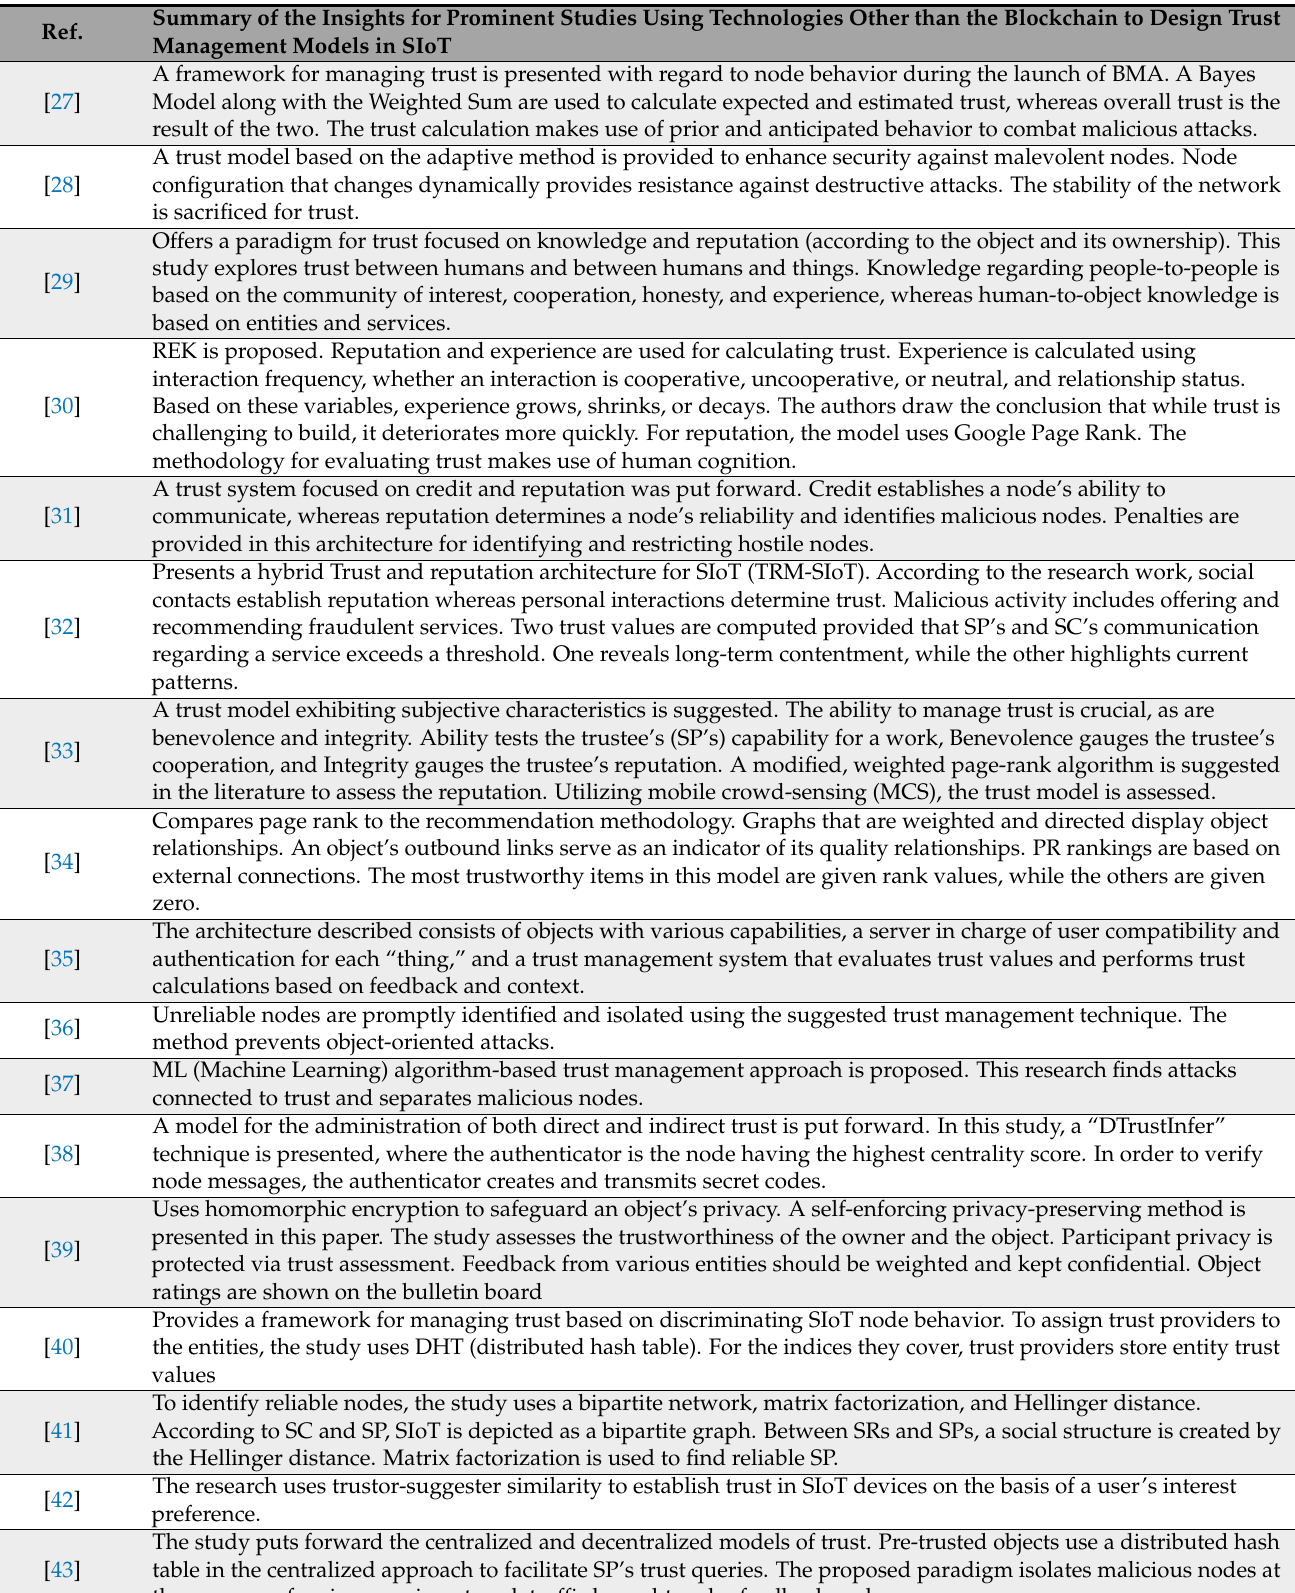
Table 1. Prominent studies using technologies other than the blockchain to design trust management models in